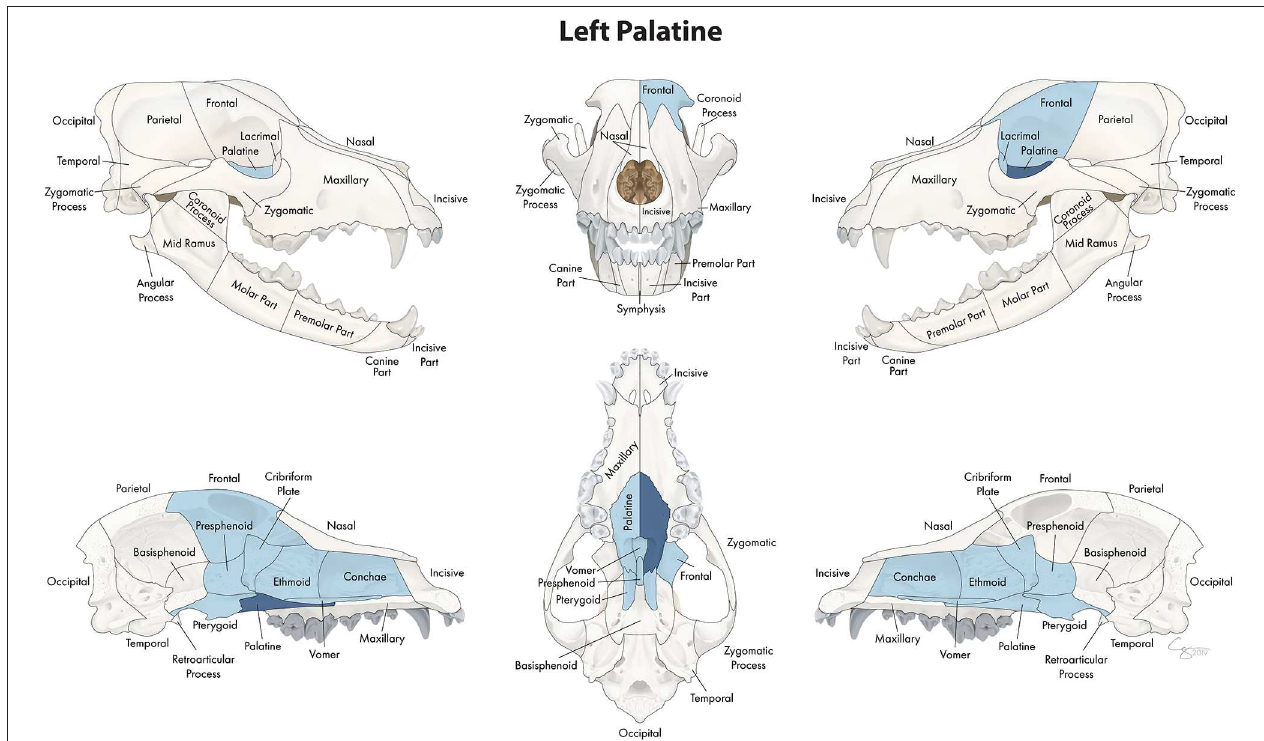
FIGURE 8 | Significant bones or regions fractured concurrently with the palatine bone. When the palatine bone was the region of interest, the cribriform plate, vomer, conchae, ethmoid bone, presphenoid bone, contralateral palatine bone, bilateral pterygoid bones, and ipsilateral lacrimal and frontal bones fractured concurrently. Although the left palatine bone is shown, when the right palatine bone was the region of interest, a mirror image of concurrently fractured locations